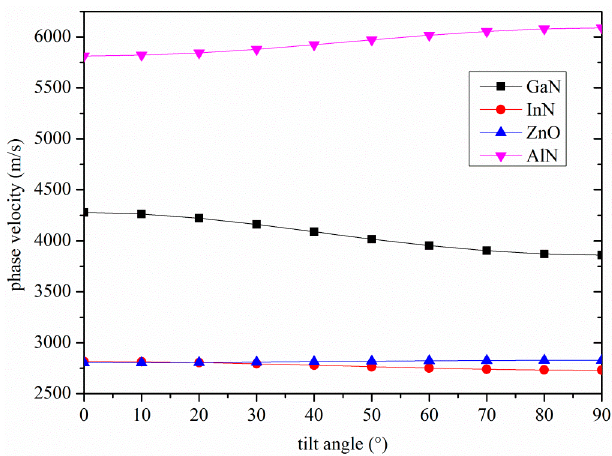
Figure 2. The phase velocity of the Love wave travelling along the x propagation direction of AlN, GaN, InN and ZnO substrates vs. the c-axis tilt angle.